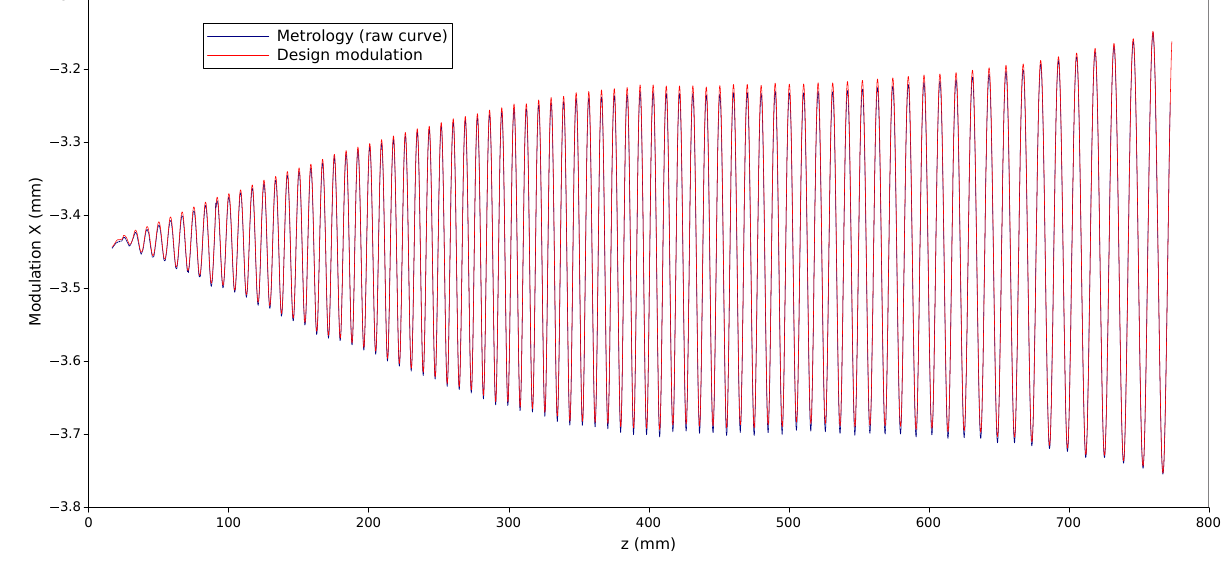
Figure 24. Comparison of measured and designed